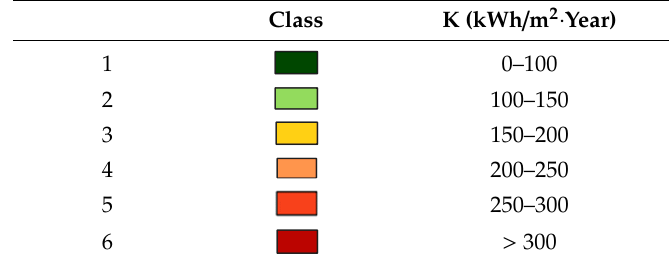
Table 1. Consumption classes according to the energy map visualization.